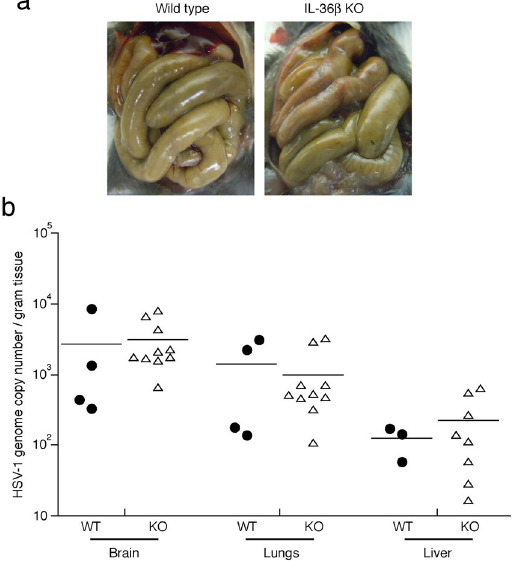
Figure 3. Mortality is associated with viral dissemination to multiple organs. ( a ) Representative images of bowels of moribund wild type and IL-36 β − / − (Fig. 2) mice are shown. ( b ) Wild type (black circles) and IL-36 β − / − (open triangles) mice were infected with 1.5 × 10 6 PFU HSV-1 on the right flank. Organs were collected from moribund mice, homogenized and HSV-1 genome copy numbers determined by QPCR. Each symbol represents a single mouse. Data is pooled from two independent experiments. No statistical significant differences were observed between wild type and IL-36 β deficient